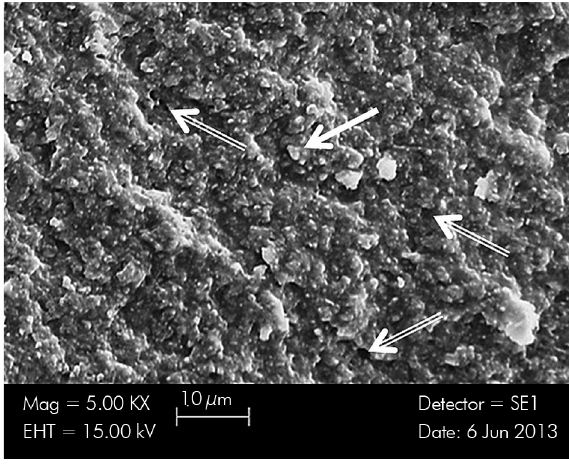
Figure 1. SEM image (5000x) of the fracture surface of the BFS-initial specimen of the control group. Double-trace arrows: sites where particles became detached; single-trace arrow: filler covered by resin